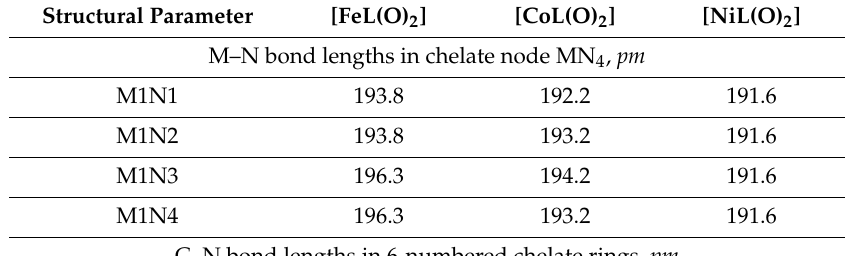
Table 1. Bond lengths and bond angles in the [M L (O) 2 ] complexes of Type I (M = Fe, Co, Ni). Structural Parameter